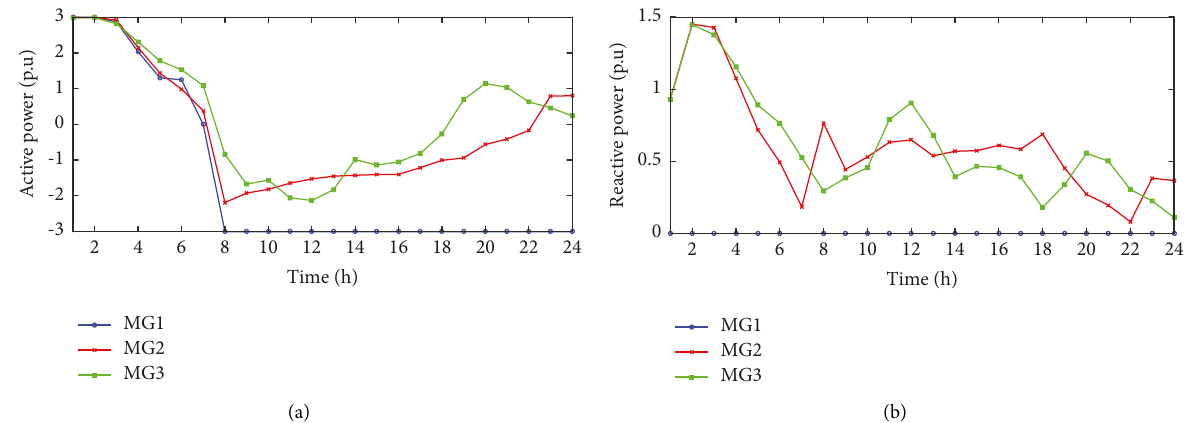
Figure 7: Daily expected power curve of different MGs in the SDN: (a) active power; (b) reactive